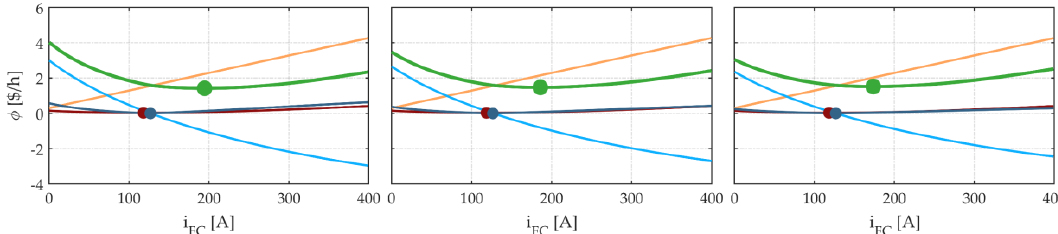
Figure 4. Evolution of the cost functions with i FC at p M = 0 kW and ε B = 0.3 ( left ), 0.5 ( middle ) and 0.7 ( right ), in which the minimum value of some curves has been highlighted by a dot: φ FC (red), φ H2 (orange), φ B (blue), φ ST (cyan), and φ (green).